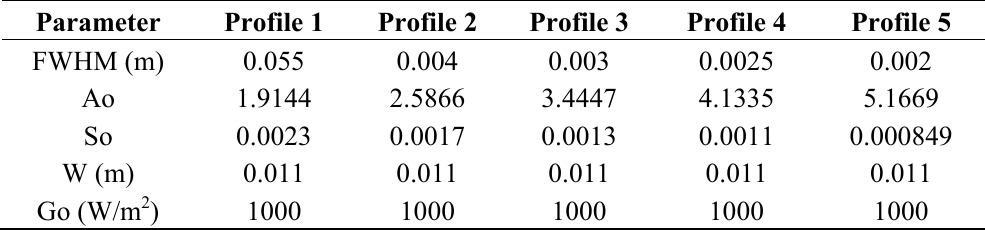
Table 5. Parameters for each illumination